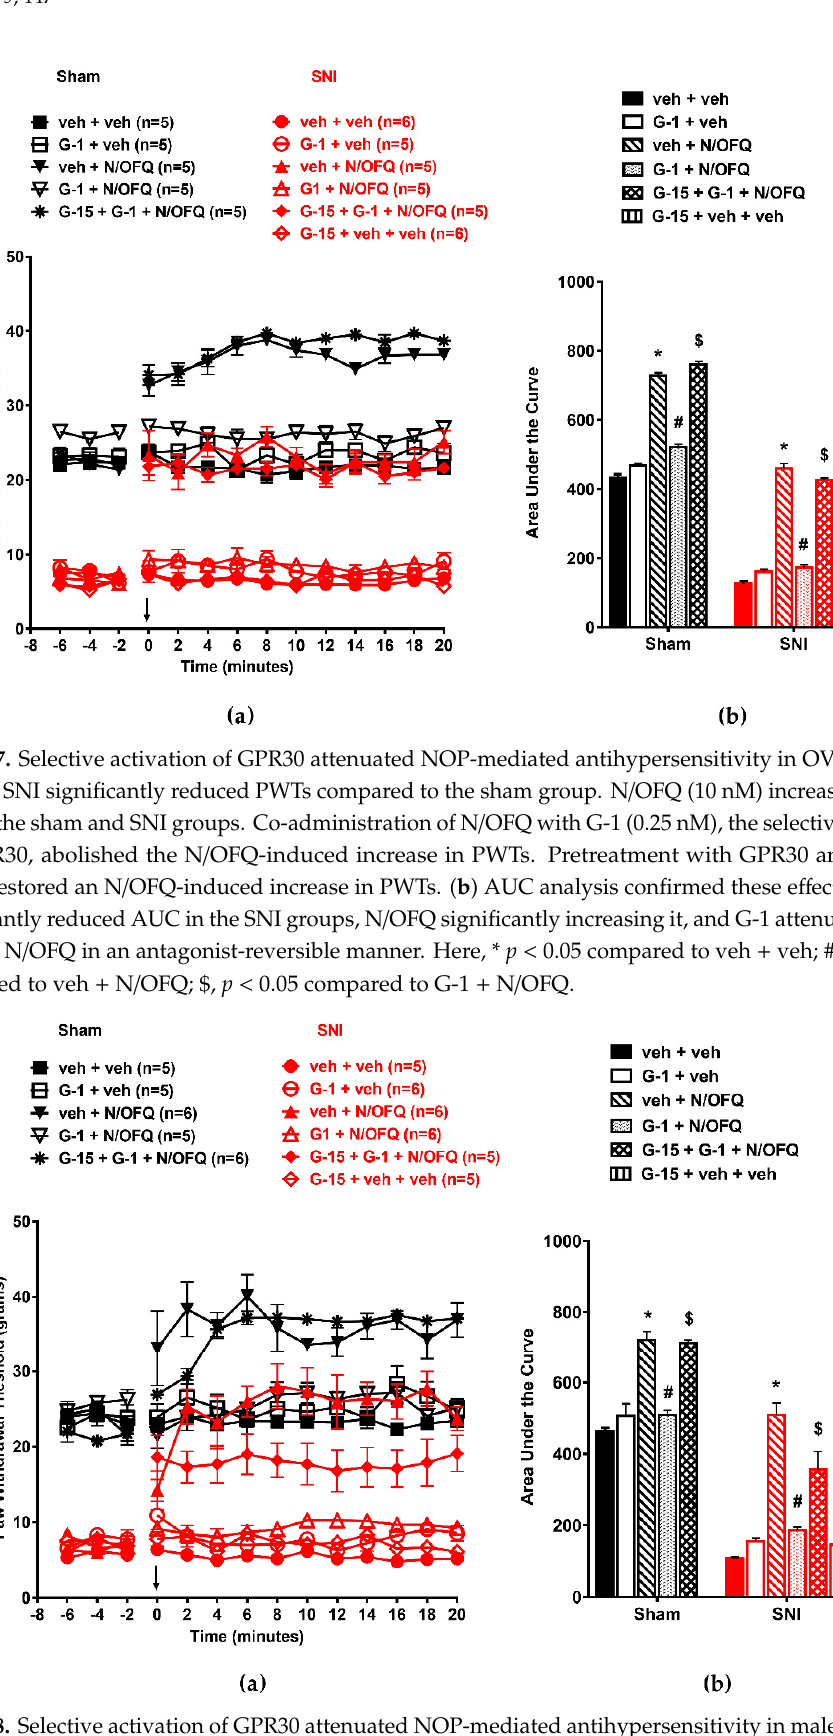
Figure 8. Selective activation of GPR30 attenuated NOP-mediated antihypersensitivity in male animals: ( a ) SNI significantly reduced PWTs compared to the sham group. N/OFQ (10 nM) increased PWTs in both the sham and SNI groups. G-1 (0.25 nM) abolished the N/OFQ-induced increase in PWTs. Pretreatment with GPR30 antagonist (G-15) restored an N/OFQ-induced increase in PWTs. ( b ) AUC analysis confirmed these effects, with a significantly reduced AUC in the SNI groups, N/OFQ significantly increasing it, and G-1 attenuating the effect of N/OFQ in an antagonist-reversible manner. Here, * p < 0.05 compared to veh + veh; #, p < 0.05 compared to veh + N/OFQ; $, p < 0.05 compared to G-1 + N/OFQ. 3.5. Selective Activation of Gq-mER Rapidly Abolished the Effects of N/OFQ The role of Gq-mER activation was determined using the selective ligand STX. In OVX animals, SNI significantly reduced the PWTs compared to the sham group ( F (130,520) = 12.45; p < 0.05; Figure 9a). N/OFQ administered intrathecally significantly increased PWTs compared to the vehicle-treated group ( p < 0.05). STX co-administration inhibited the N/OFQ-induced increase in PWTs in the SNI group ( p < 0.05). In sham animals, N/OFQ increased PWTs above baseline at time points 0–20 ( F (13,520) = 51.14; p < 0.05), and STX co-administration blocked the N/OFQ-induced increase in PWTs ( p < 0.05). Blocking Gq-mER with ICI-182,780 restored the effect of N/OFQ (Figure 9a). Similar effects were observed on the AUCs ( F (10,50) = 160.38; p < 0.05; Figure 9b).